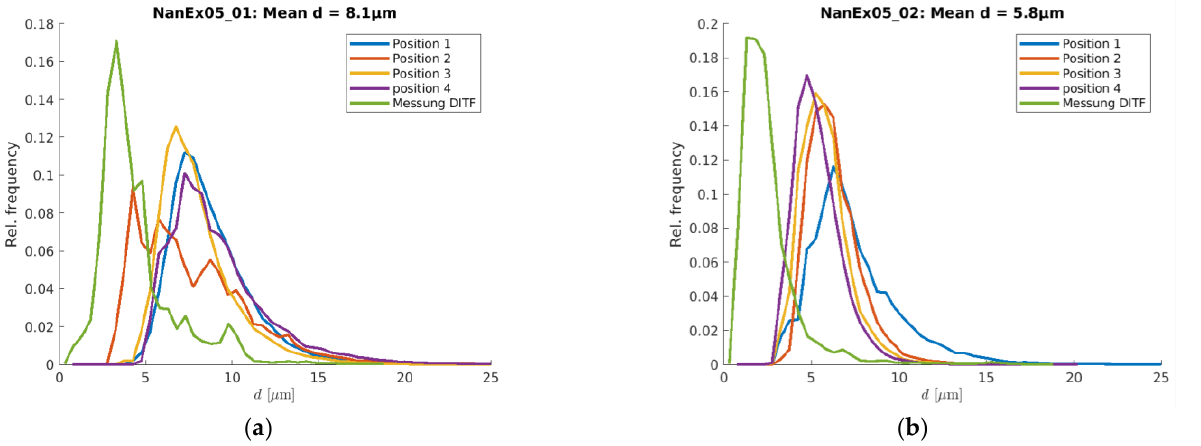
Figure 13. Comparison of diameter distribution of measurement and simulation for two scenarios, based on experiments with PPHL712FB ( T melt = 300°C, 𝑉̇ = 3.8 g . ho . min −1 ): ( a ) 𝑉̇ 𝑎𝑖𝑟 = 220 Nm 3. h −1 ; ( b ) 𝑉̇ 𝑎𝑖𝑟 = 440 Nm 3. h −1 .